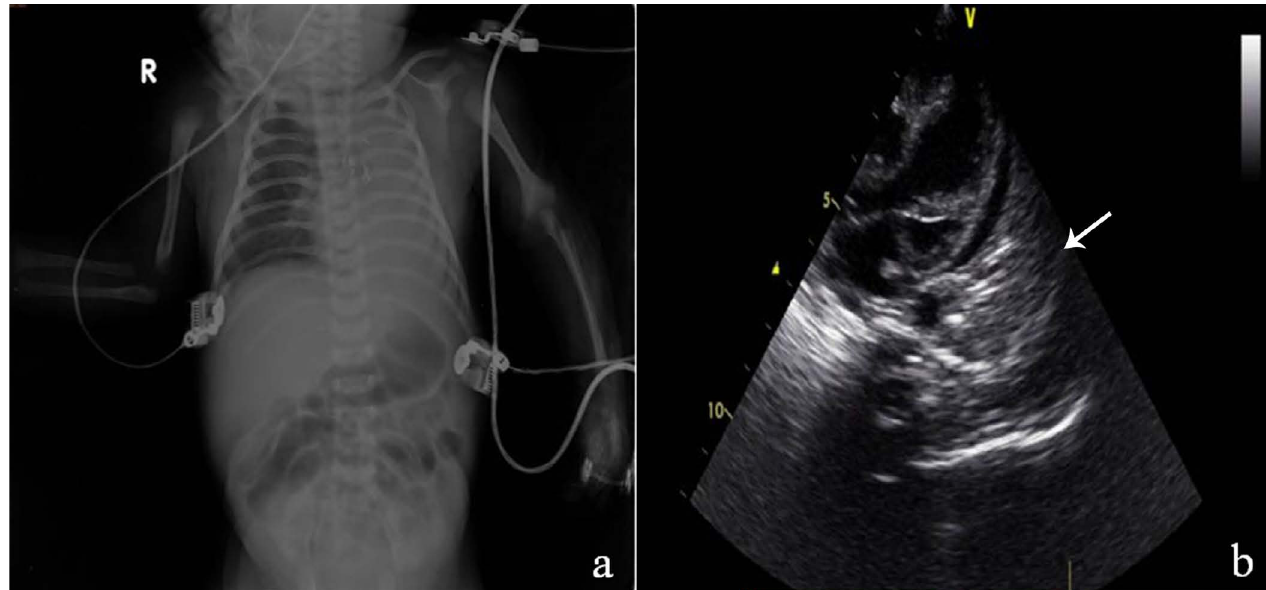
Fig. 1 - A 19-day old patient, operated for coarctation of aorta, on the 5 th postoperative day. A) Chest X-ray revealed increased opacity on the left lung and B) Thorax USG showed lung consolidation with clearly demarcated